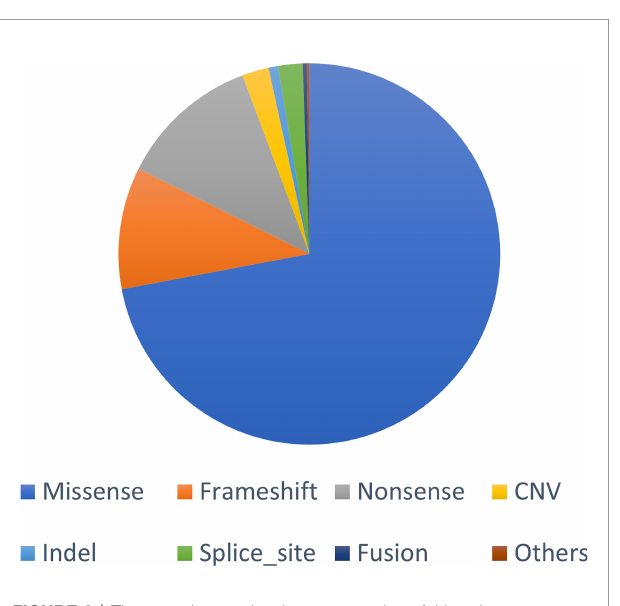
FIGURE 2 | The somatic mutational type proportion of this cohort.